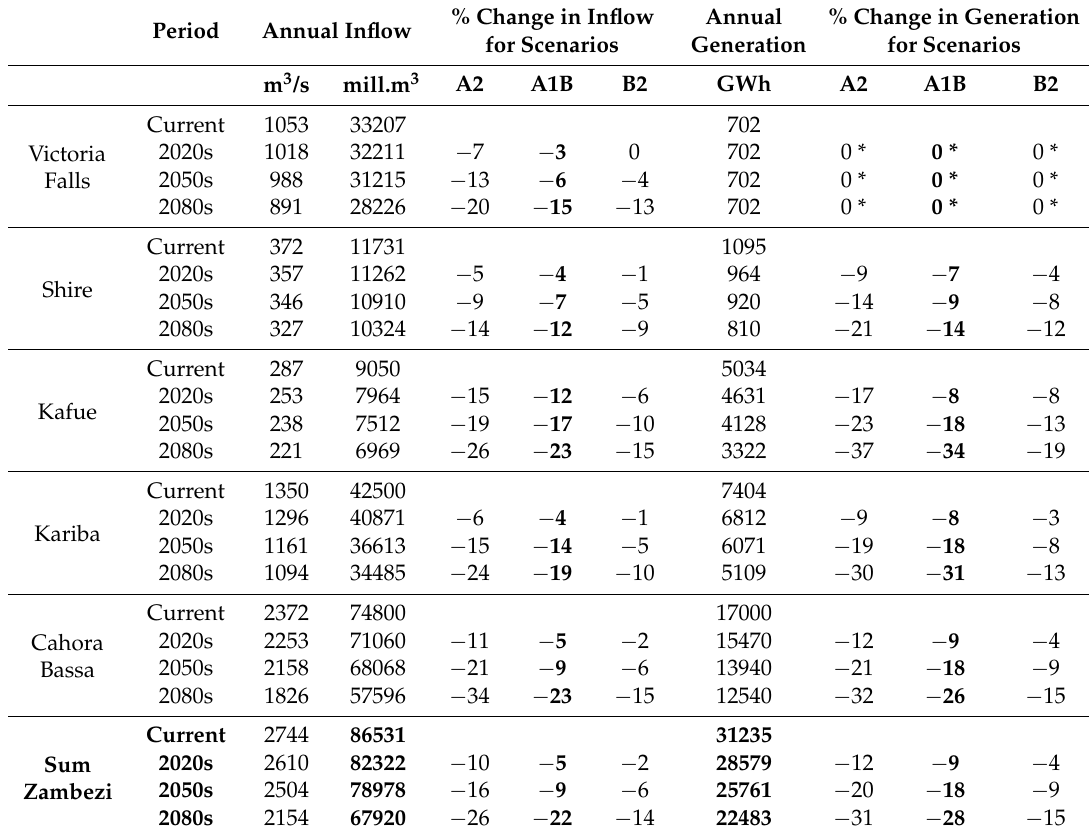
Table 8. Changes in production at selected groups of hydropower stations in the Zambezi basin for different emission